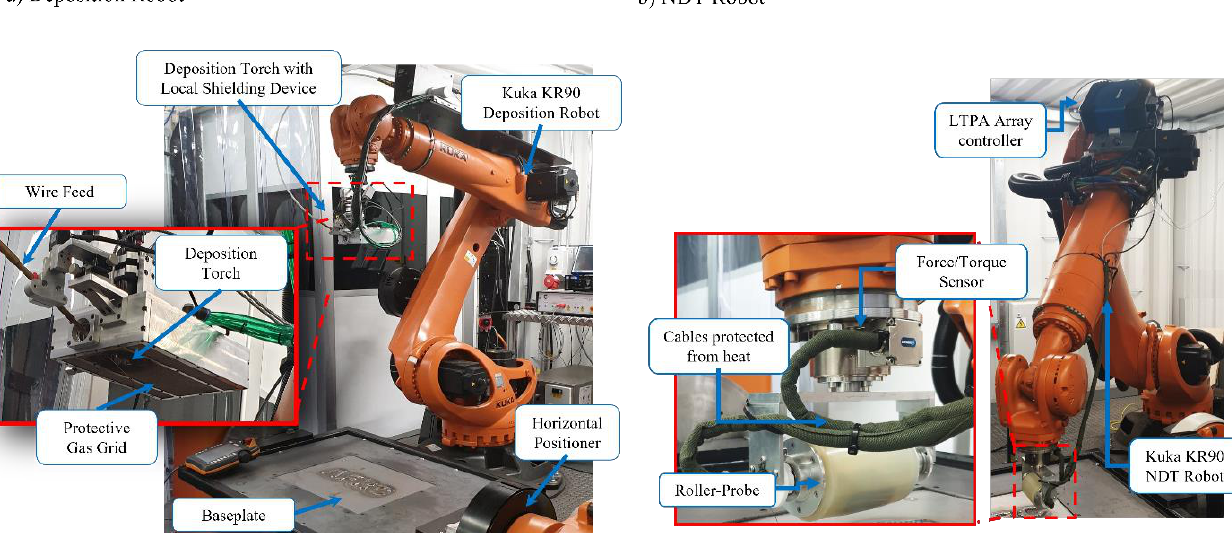
Figure 1. Implemented ( a ) WAAM deposition cell with plasma arc process, and ( b ) Roller-Probe based NDE.